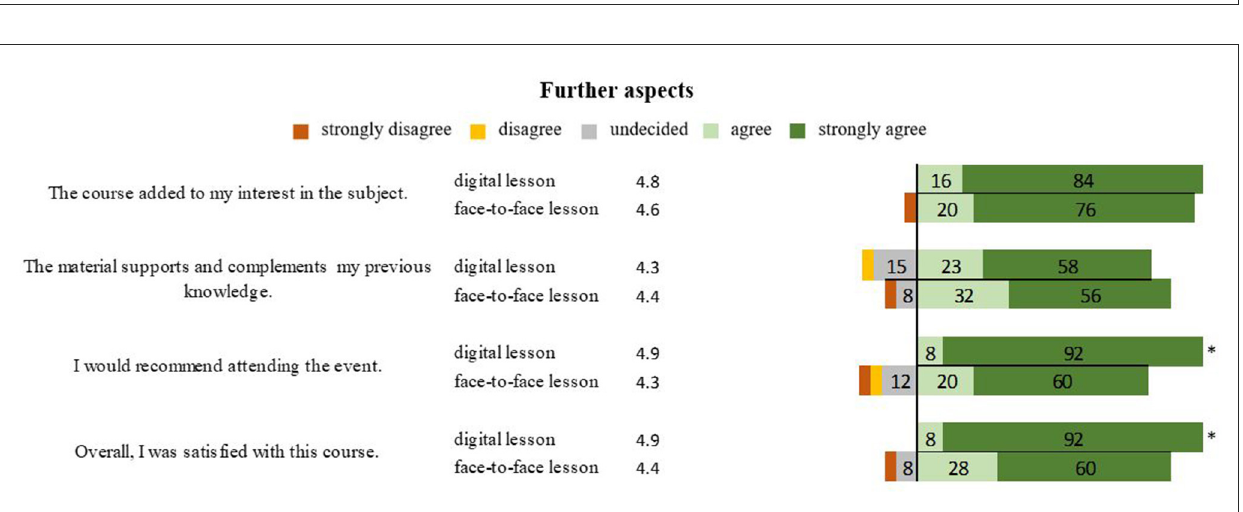
FIGURE5 Presentation of students’ opinions on the aspects of interesting and recommendable design in digital and face-to-face teaching in percentages. *Marks significant differences.